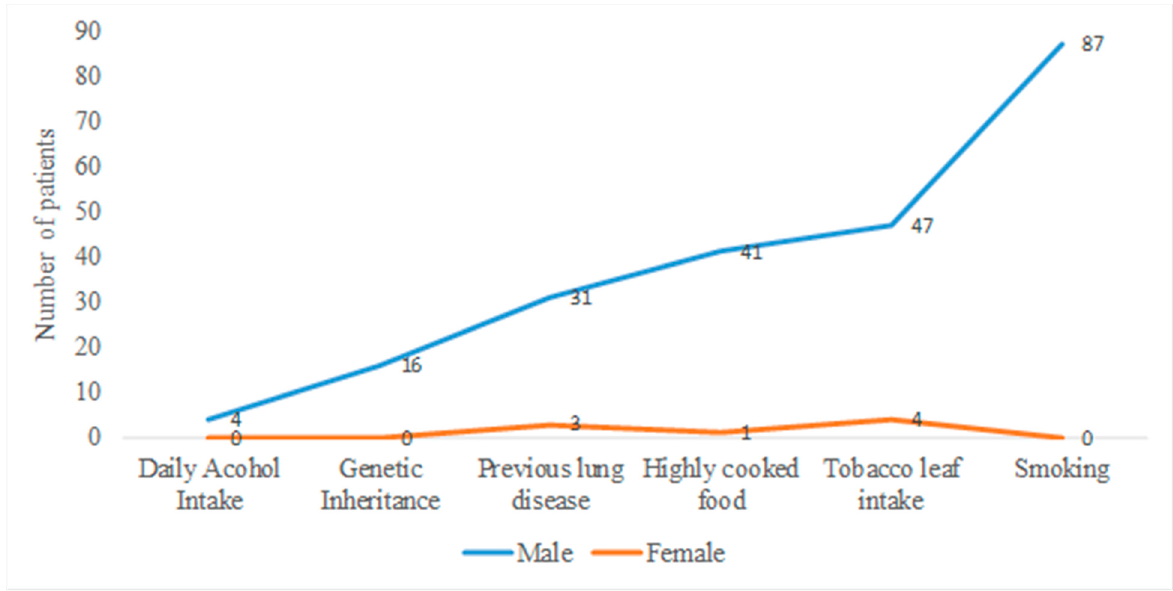
Figure 1. Line graph showing prevalence of lung cancer among Bangladeshi males and females. For males, smoking is the most common contributing factor in cancer development, and for females it is tobacco leaf intake. Men are more susceptible to lung cancer than women, as the rate of smoking is higher rate among men, but tobacco leaf use is increasing lung carcinoma rates among women.